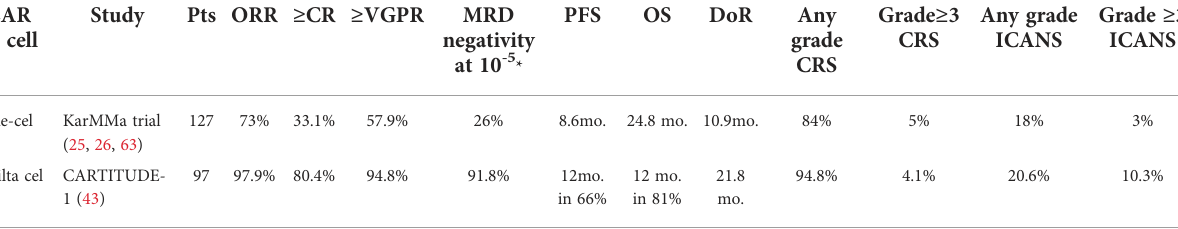
TABLE 3 Ide-cel versus cilta-cel based on their ef fi cacy and adverse events in MM treatment based on KarMMa trial and CARTITUDE- 1. CAR T